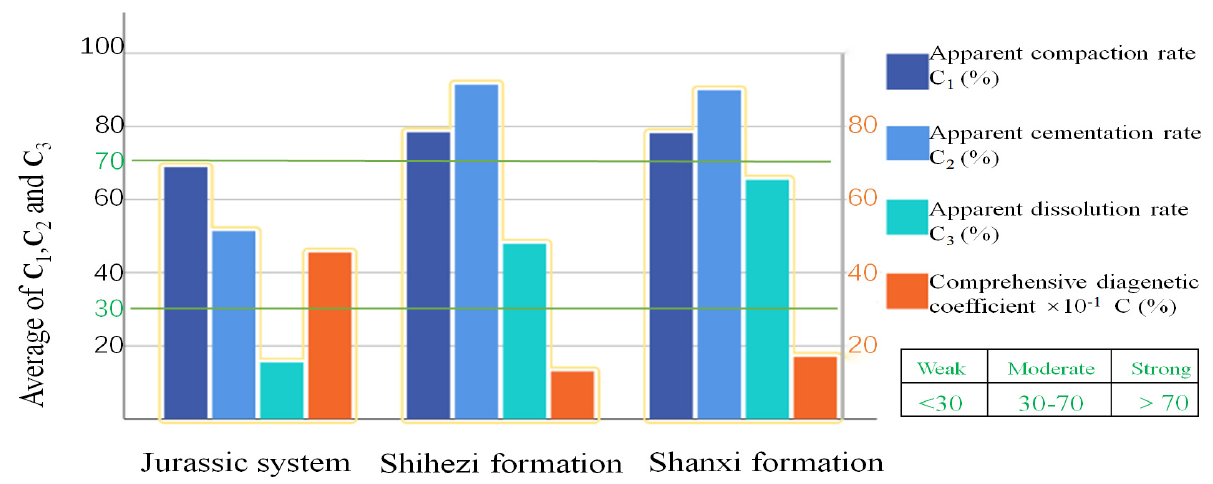
Figure 9. The main diagenesis indicators of the three layers of deep-mine sandstone.